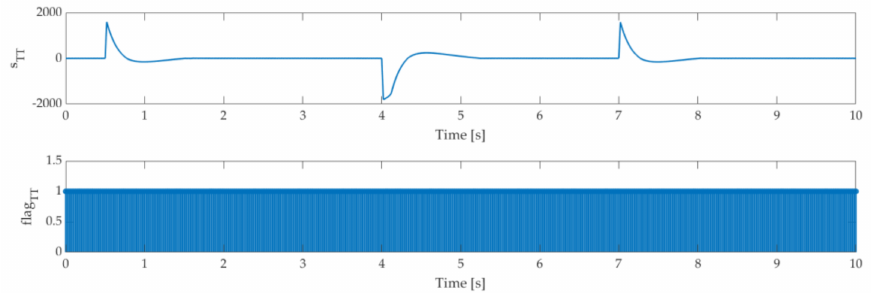
Figure 3. Sliding variable evolution of the closed-loop system with controller u TT and fixed sa-mpling time T s